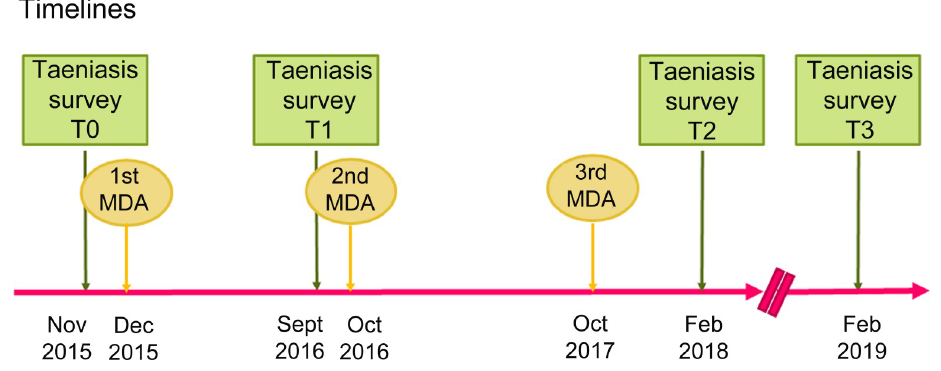
Fig 2. Timelines of the 3-year MDA pilot project for taeniasis control in Madagascar.